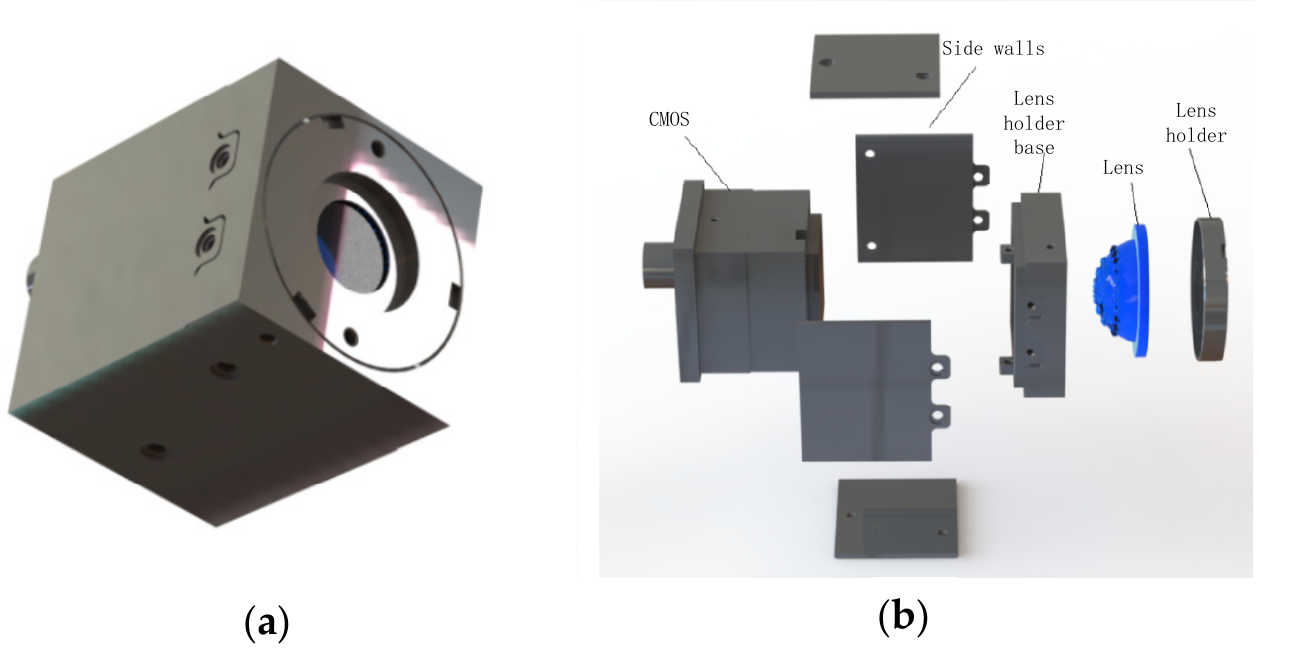
Figure 1. Three-dimensional massive structure of the compound eye camera. ( a ) Photo of the prototype; ( b ) exploded view of the camera.